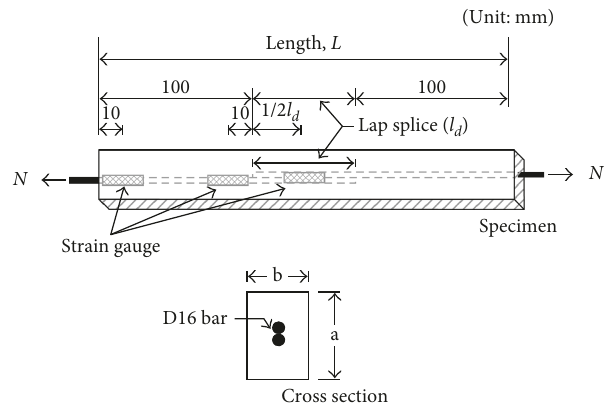
Figure 1: Schematic drawing for